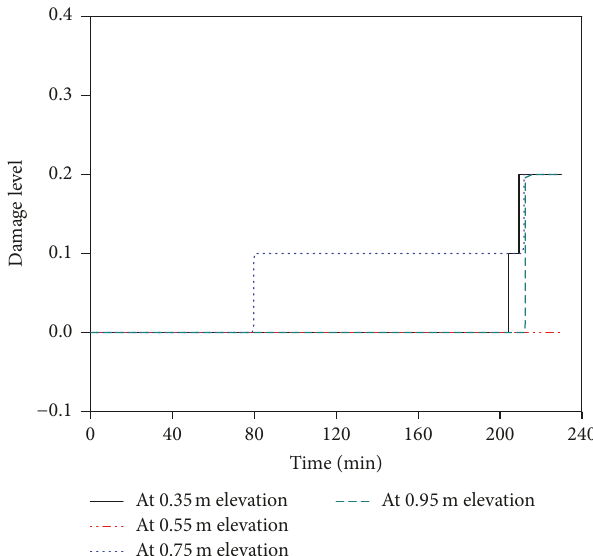
Figure 13: Damage level states of fuel bundle predicted by the RELAP/SCDAPSIM/MOD3.4